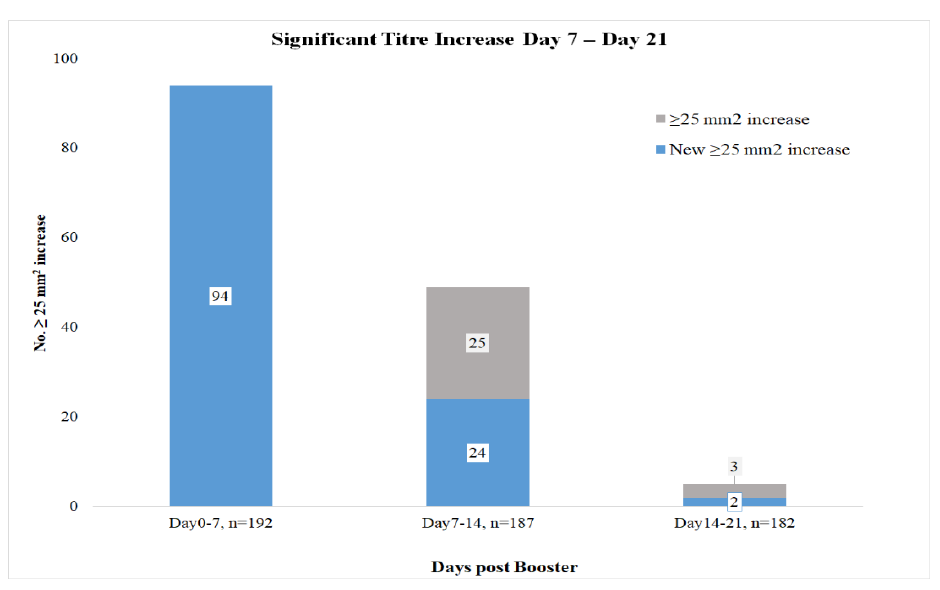
Figure 1. Number of horses with an increase in single radial haemolysis (SRH) titre of ≥25 mm 2 between the day of booster vaccination (day 0) and day 7 post-vaccination, between day 7 and day 14 post-vaccination, and between day 14 and 21 post-vaccination.